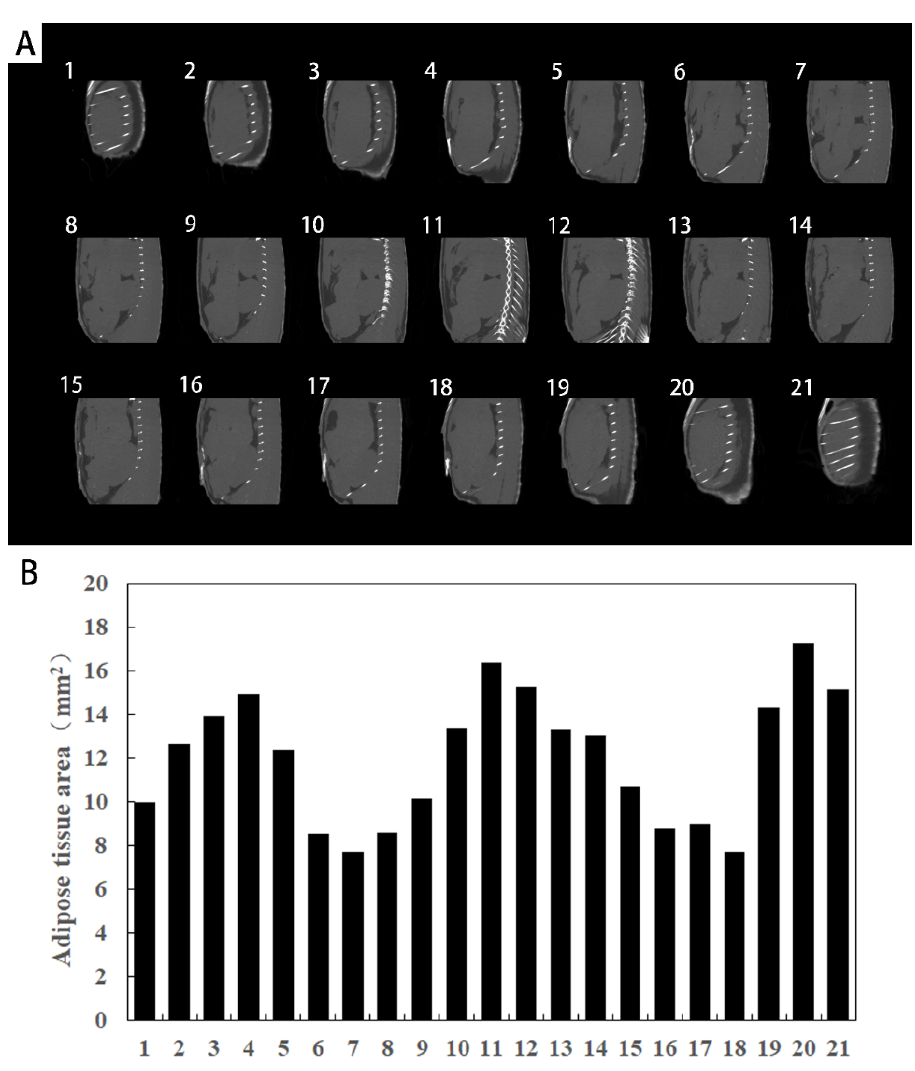
Figure 10. Continuous sagittal CT scan of the adipose tissue of the zebrafish trunk ( A ) and the area of each slice of adipose tissue ( B ).